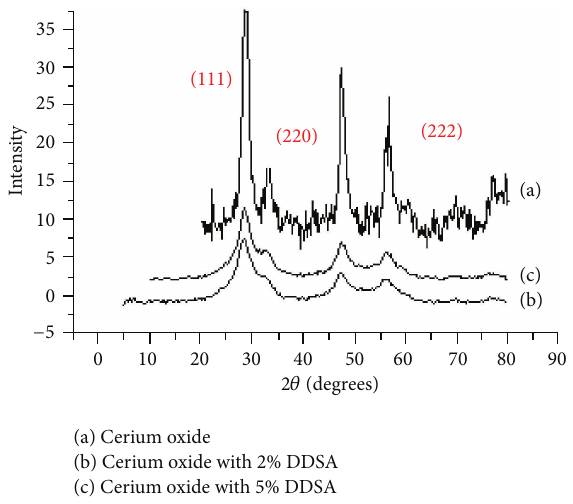
Figure 3: X-Ray Diffraction pattern of cerium oxide nanoparticles.